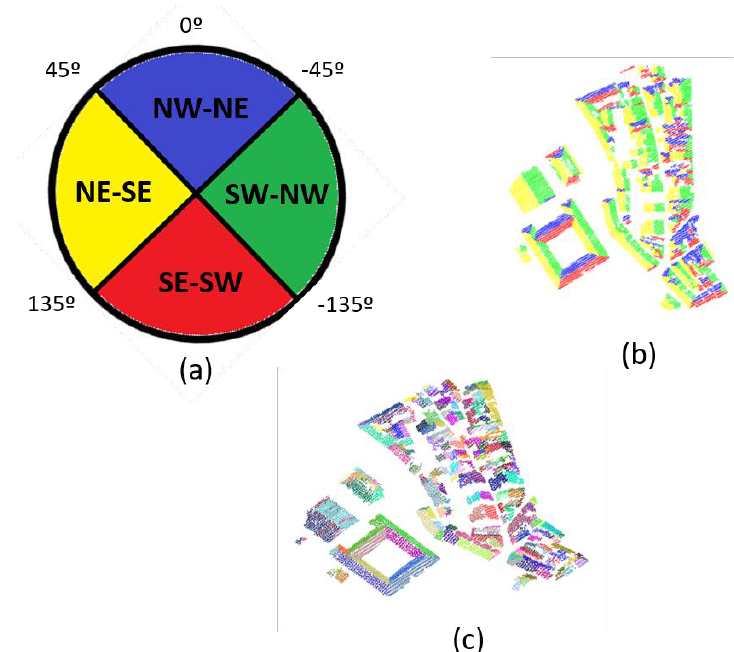
Figure 4. Roof parametrization. ( a ) Four orientation indices are defined for each point: North West-North East, North East-South East, South East-South West and South West-North West. ( b ) Visualization of the orientation of each point in the cloud P r . ( c ) Result of the orientation-driven Euclidean Clustering process. Each cluster is represented in a random color.